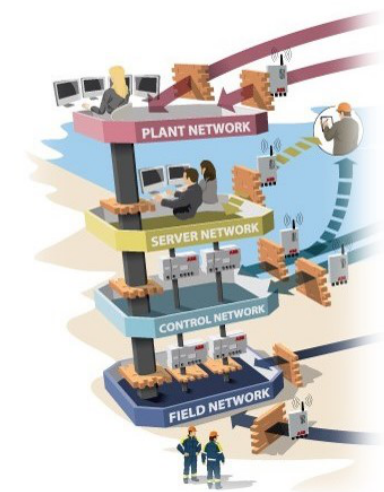
Figure 1. The traditional and hierarchical automation pyramid that has been the de facto standard for three